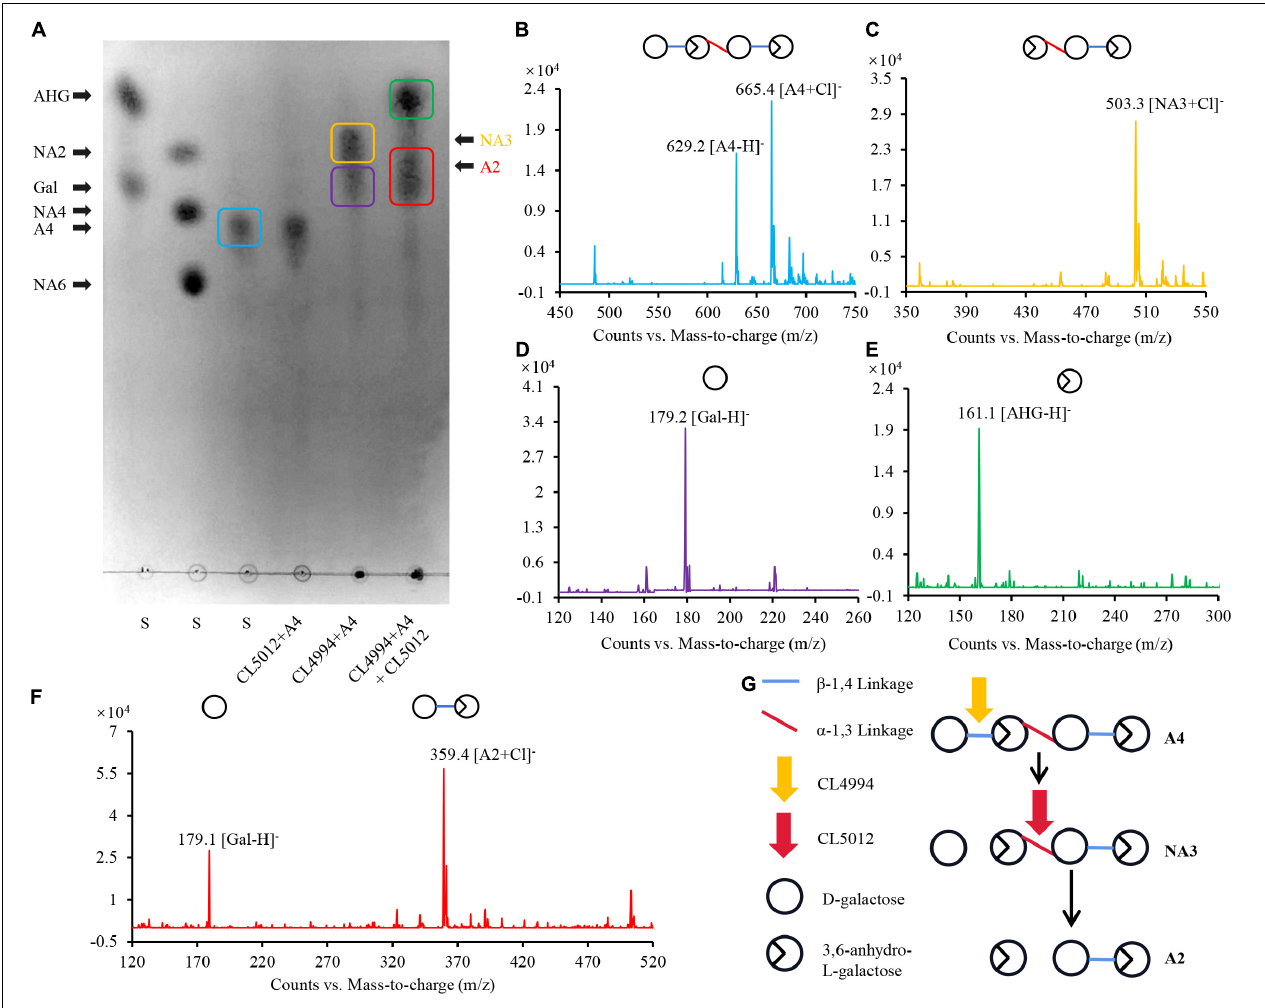
FIGURE 3 | Analysis of depolymerization process of agarotetraose by agarolytic β -galactosidase CL4994 and α -NAOS hydrolase CL5012. (A) TLC analysis of hydrolysis products of CL5012, CL4994 incubated with agarotetraose, respectively. (B) Mass spectrum of one spot corresponding to agarotetraose. (C) Mass spectrum of one spot corresponding to neoagarotriose. (D) Mass spectrum of one spot corresponding to D-galactose. (E) Mass spectrum of one spot corresponding to L-AHG. (F) Mass spectrum of two spots corresponding to agarobiose and D-galactose. (G) Schematic model of depolymerization of agarotetraose by CL4994 and CL5012. AHG, 3,6-anhydro-L-galactose; A2, agarobiose; A4, agarotetraose; Gal, D-galactose; NA3, neoagarotriose; S, standard